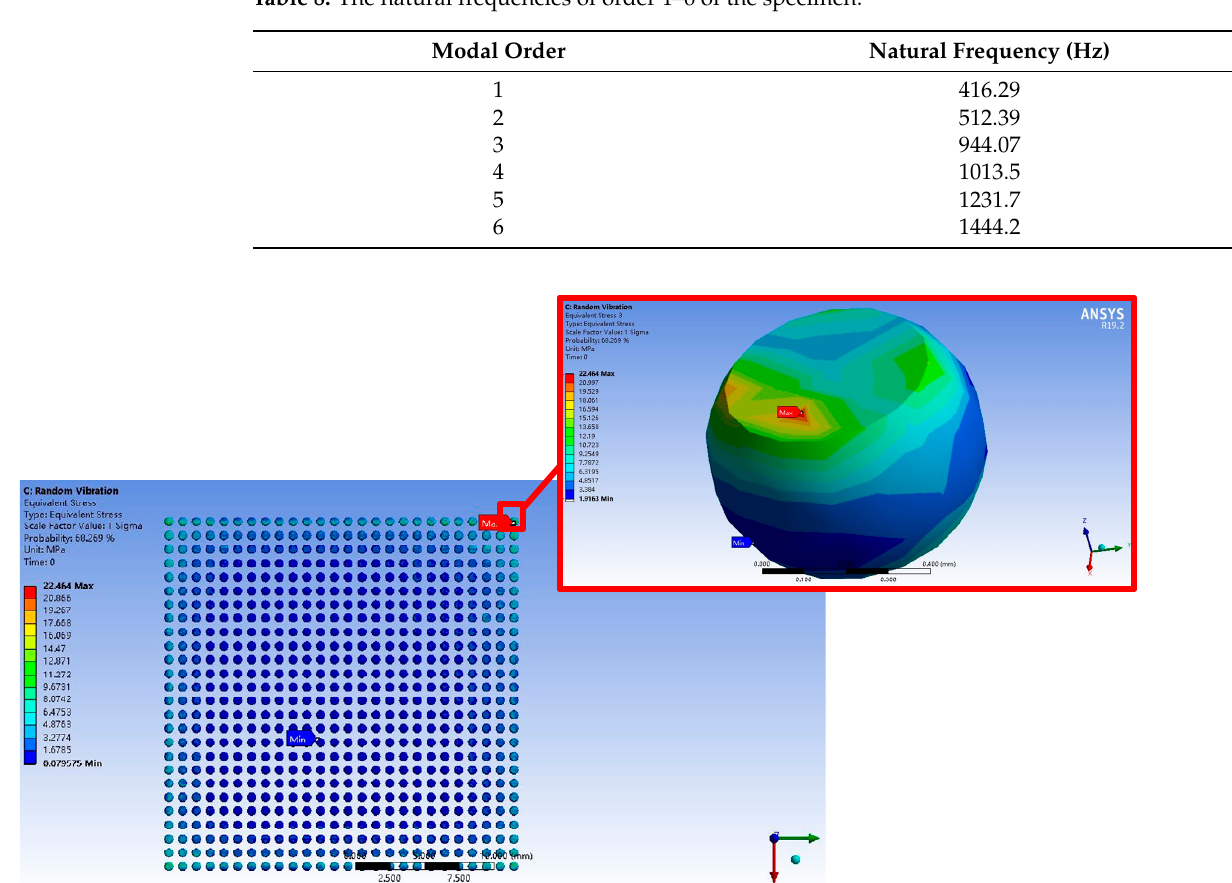
Figure 13. The distribution of equivalent stress of 1 σ in D101.